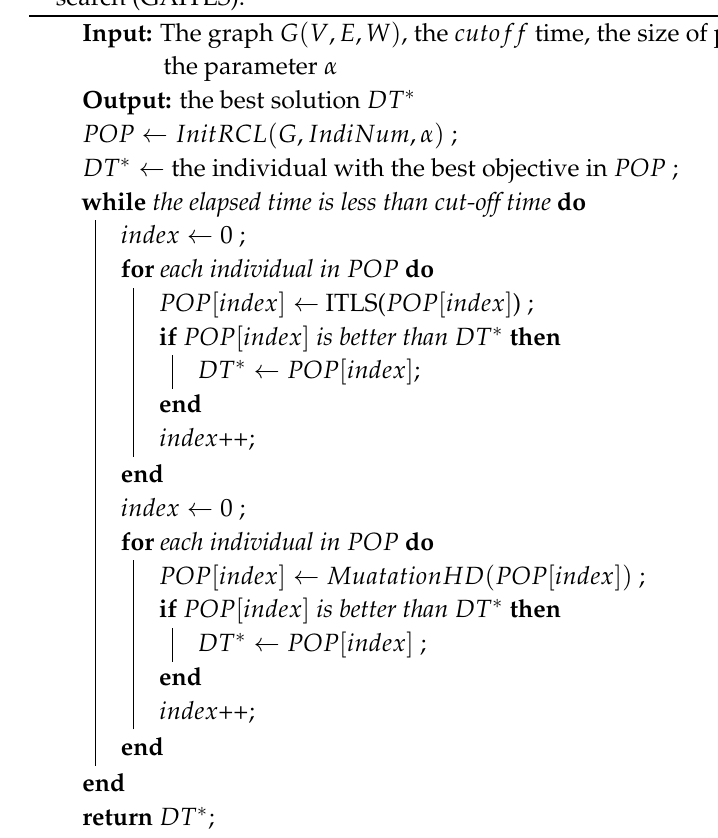
Algorithm 3: The hybrid framework combining genetic algorithm with iterated local search